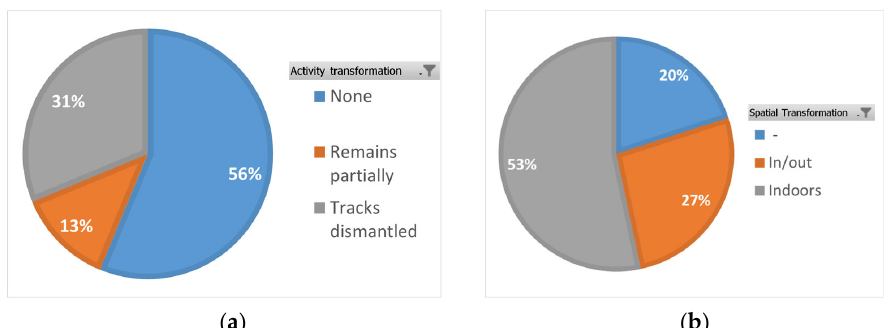
Figure 4. ( a ) Activity transformation in the stations analyzed. Own elaboration. ( b ) Spatial transfor- mation in the stations analyzed. Own